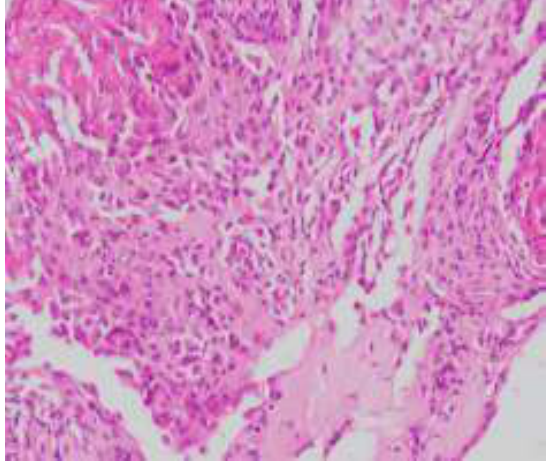
Figure 3: Lung biopsy showed few hemosiderin-laden macrophages, broken alveolar septa, central